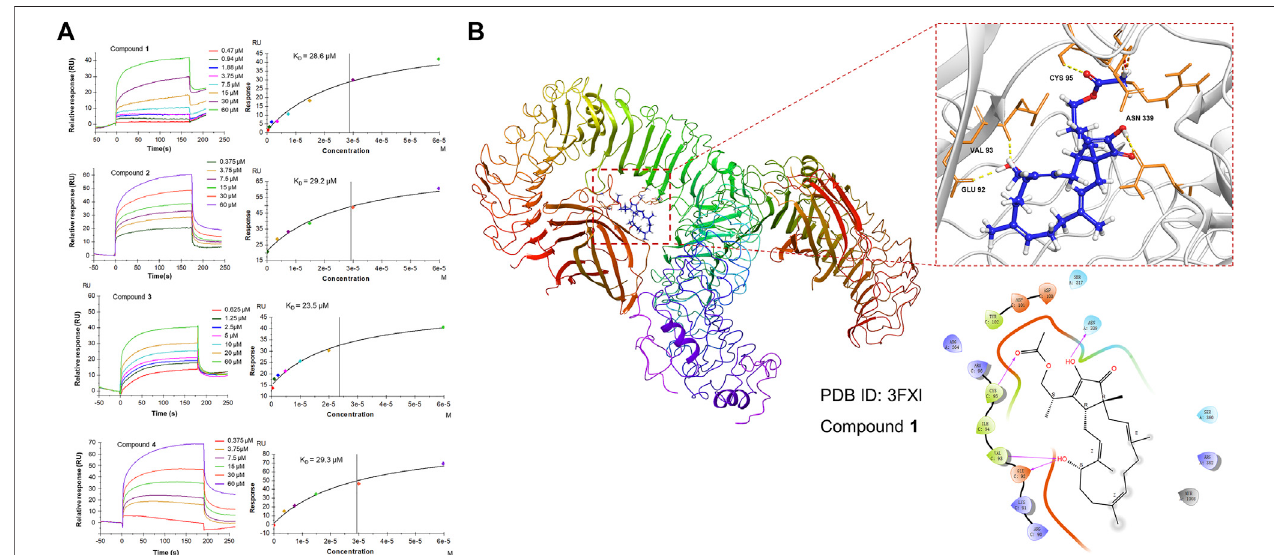
FIGURE7|(A) SPRanalysisofthebindingaf fi nityof 1 - 4 totheTLR4protein.Apparentequilibriumdissociationconstants(KD)werethencalculatedbyglobal fi tting using a steady-state af fi nity model in Biacore T200 evaluation software. The KD values of 1 - 4 were 28.6, 29.2, 23.5, and 29.3 μ M, respectively. (B) Structures and orthogonal views of the pocket of binding between 1 and TLR4-MD-2 (PDB ID: 3FXI). Molecular docking simulations were obtained at the lowest energy conformation. Hydrogen bonding interactions are shown by dashes.